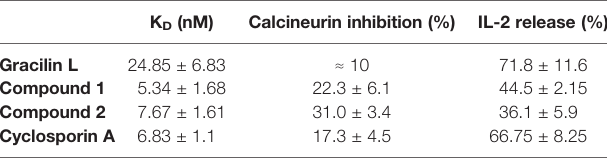
TABLE 1 | Kinetic equilibrium dissociation constant (K D ) values for binding of Spongionella derived compounds and CsA to